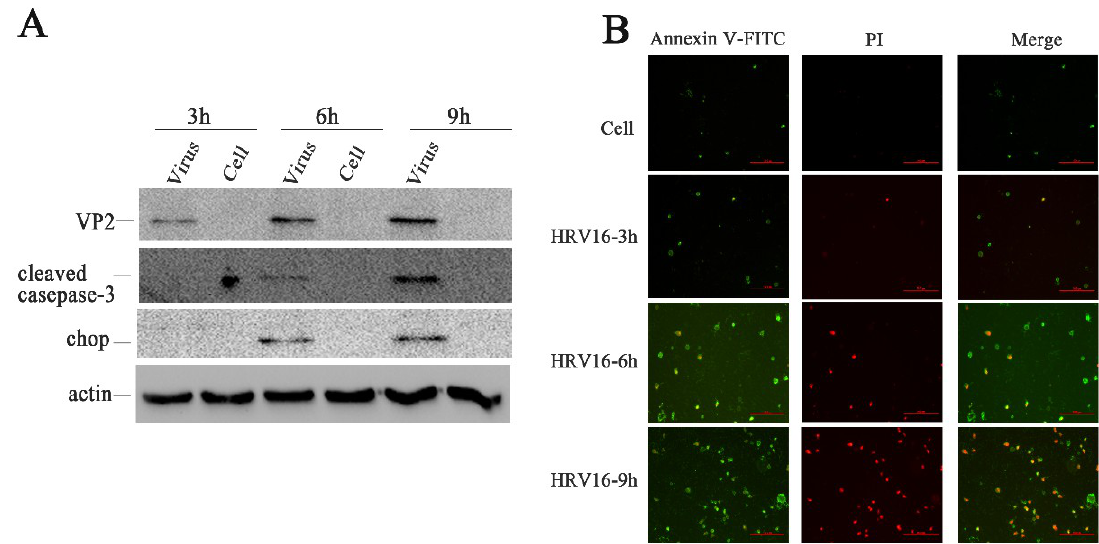
Figure 3. HRV16 infection induced apoptosis. ( A ) The expressions of VP2, cleaved caspase-3, CHOP, and actin were detected in H1-HeLa cells infected with HRV16 for 3 h, 6 h and 9 h by Western blotting. Uninfected cells were used as controls. ( B ) After infection for 3 h, 6 h and 9 h, H1-HeLa cells were stained with FITC-labeled annexin V and propidium iodide. Early apoptotic cells (annexin V+ /PI − ) were green. Late apoptotic cells were red and green (annexin V/PI+). Scale bars of images, 200 μm.